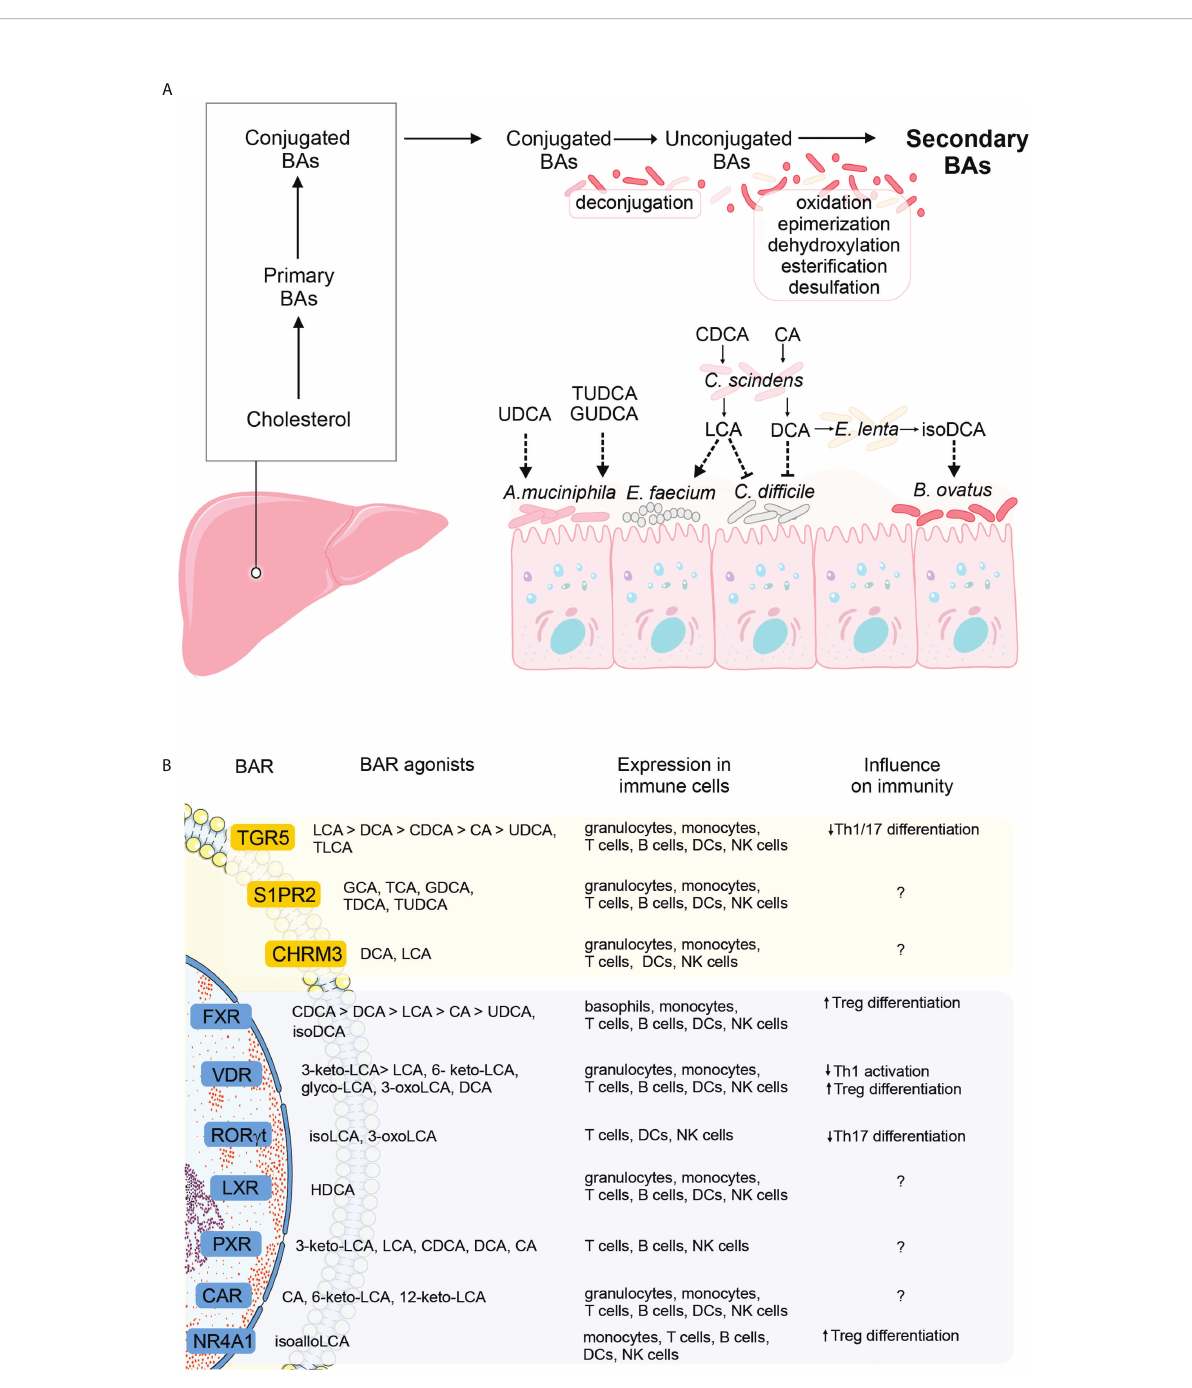
FIGURE 1 The in fl uence of bile acid (BA) metabolism on the gut microbiome and host immunity. (A) Primary BAs are produced from cholesterol in the liver, conjugated to glycine or taurine, and secreted into the gut lumen. In the intestine, primary BAs undergo un-conjugation by the microbiota, followed by further rounds of modi fi cations (oxidation and epimerization, dehydroxylation, esteri fi cation, or desulfation), to yield secondary BAs. Conjugated, unconjugated, and secondary BAs can all shape the microbial composition in the intestine (dashed arrows). Speci fi c examples include unconjugated and taurine or glycine-conjugated UDCA promoting the growth of A municiphila , LCA derived from the conversion of CDCA by C scindens and promoting the growth of E faecium while inhibiting the growth of C dif fi cile , DCA, derived from the conversion of CA by C scindens and inhibiting the growth of C dif fi cile and fi nally, isoDCA, derived from the conversion of DCA by E lenta , and promoting the growth of Bacteroides (see also main text). (B) Schematic overview of the G-protein coupled (yellow) and nuclear receptors (blue) speci fi c for bile acids (greater-than signs denote higher af fi nities). The panel of BARs expressed in immune cells was extracted from the Human Protein Atlas, using the HPA (26) and Monaco datasets (27). Immunomodulatory effects of receptor signaling by at least one natural ligand is noted (question marks denote receptor signaling with the in fl uence on immunity that remains to be identi fi